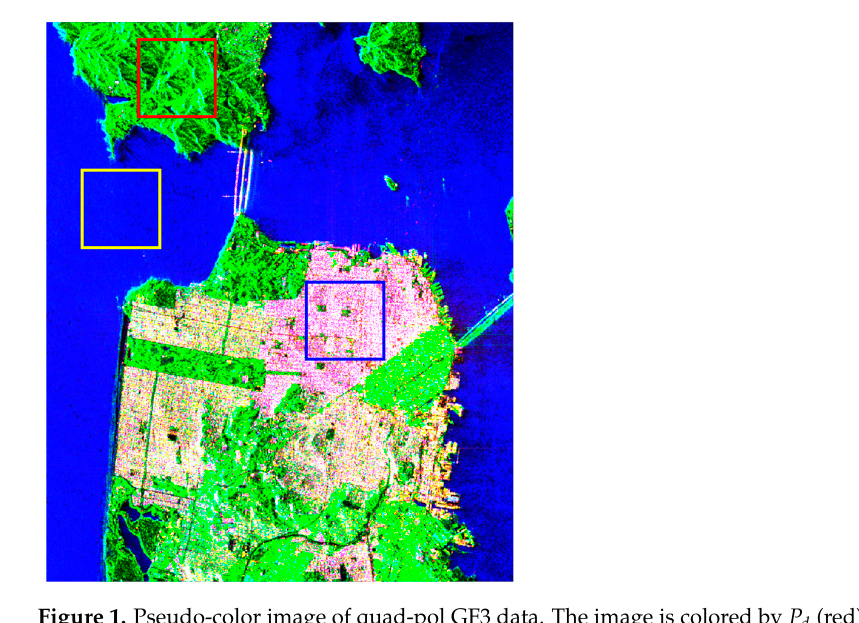
Figure 1. Pseudo-color image of quad-pol GF3 data. The image is colored by P d (red), P v (green), and P (blue). P s and s